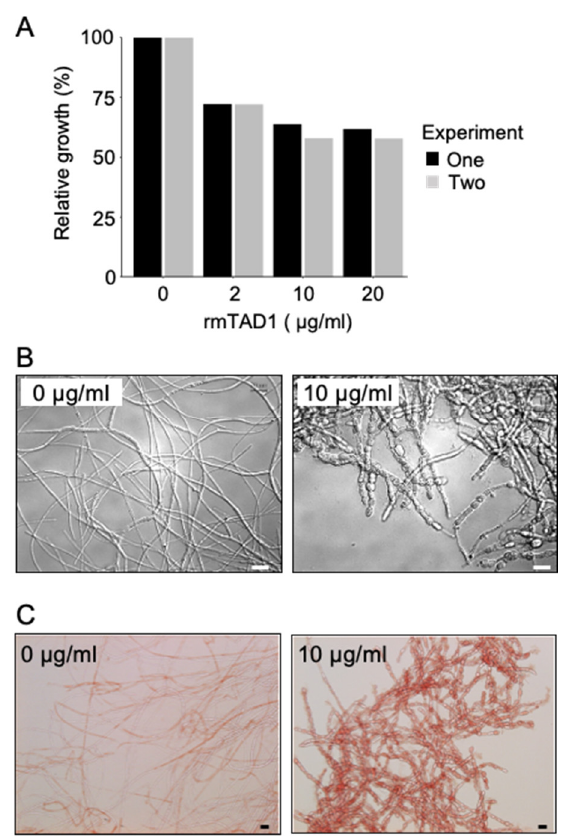
Figure 3. Antifungal activity of TAD1 to snow mold fungus M. nivale . ( A ) Relative fungus growth was estimated by cultivation of the M. nivale hyphae on a 96-well microplate and increasing the concentration of rmTAD1 (0, 2, 10, and 20 µg/mL) at 10 °C for 9 days. The hyphal growth was monitored by measuring absorbance at 595 nm and was presented as a percentage of the growth in the absence of rmTAD1. Two biological replicate experiments were performed (experiment one and two). ( B , C ) Microscopic observation of M. nivale hyphae after incubating spores at 10 °C for 9 days with or without rmTAD1 (10 µg/mL). Images of hyphae were captured by using differential interference contrast (DIC) microscopy ( B ). Mycelia were stained with Congo red ( C ). Scale bar = 20 µm.